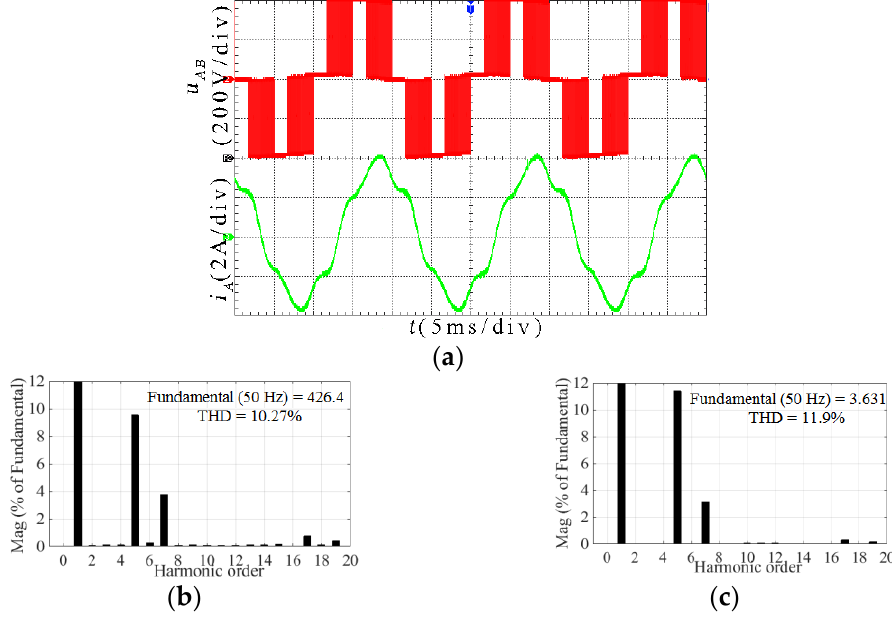
Figure 15. Experimental results for the TFOS at m = 0.615: ( a ) Line voltage u AB and line current i A ; ( b ) Spectrum analysis for u AB ; ( c ) Spectrum analysis for i A .